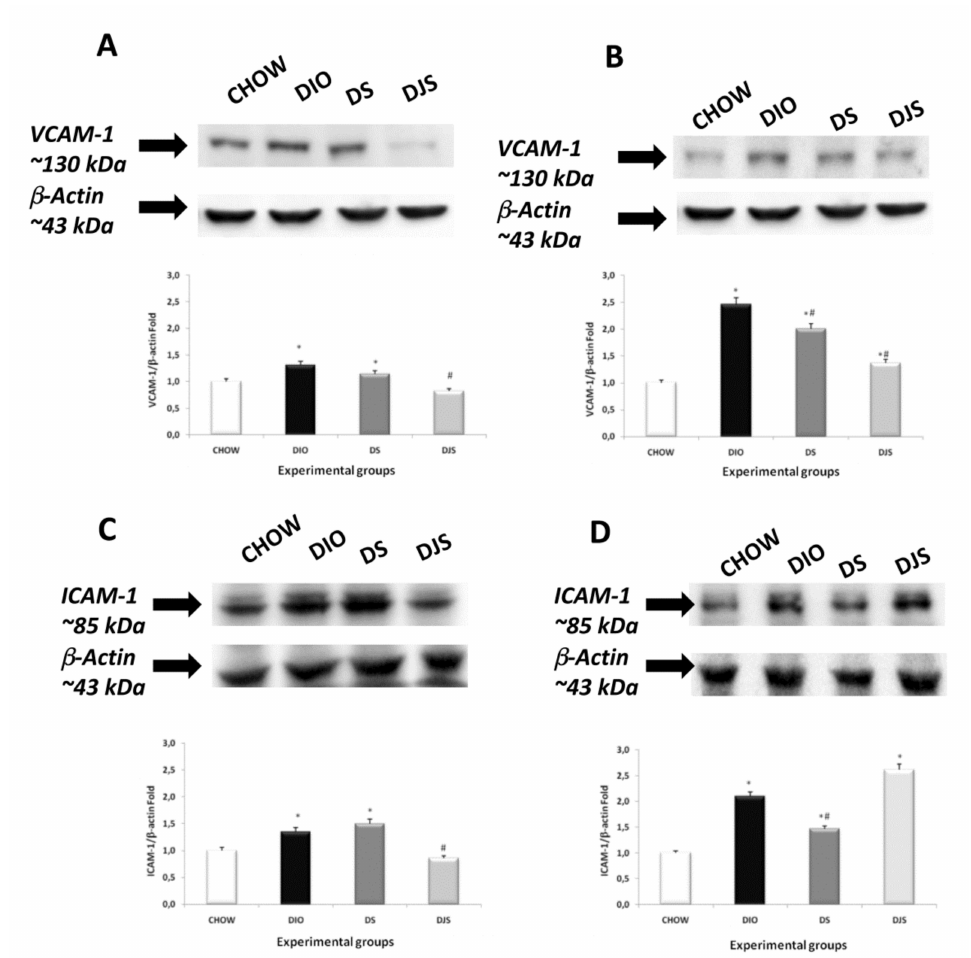
Figure 7. Western blot analysis (representative of three di ff erent experimental sessions) for VCAM-1 in the frontal cortex ( A ) and hippocampus ( B ), and for ICAM-1 in the frontal cortex ( C ) and hippocampus ( D ) of CHOW, DIO (D), DIO after supplementation with tart cherry seeds (DS), DIO after supplementation with seeds and tart cherry juice (DJS) groups. Graphs represent the intensity of bands normalized to the band intensity of reference protein ß-actin. The values are the mean ± S.E.M.; ∗ p < 0.05 vs. CHOW rats; # p < 0.05 vs. DIO